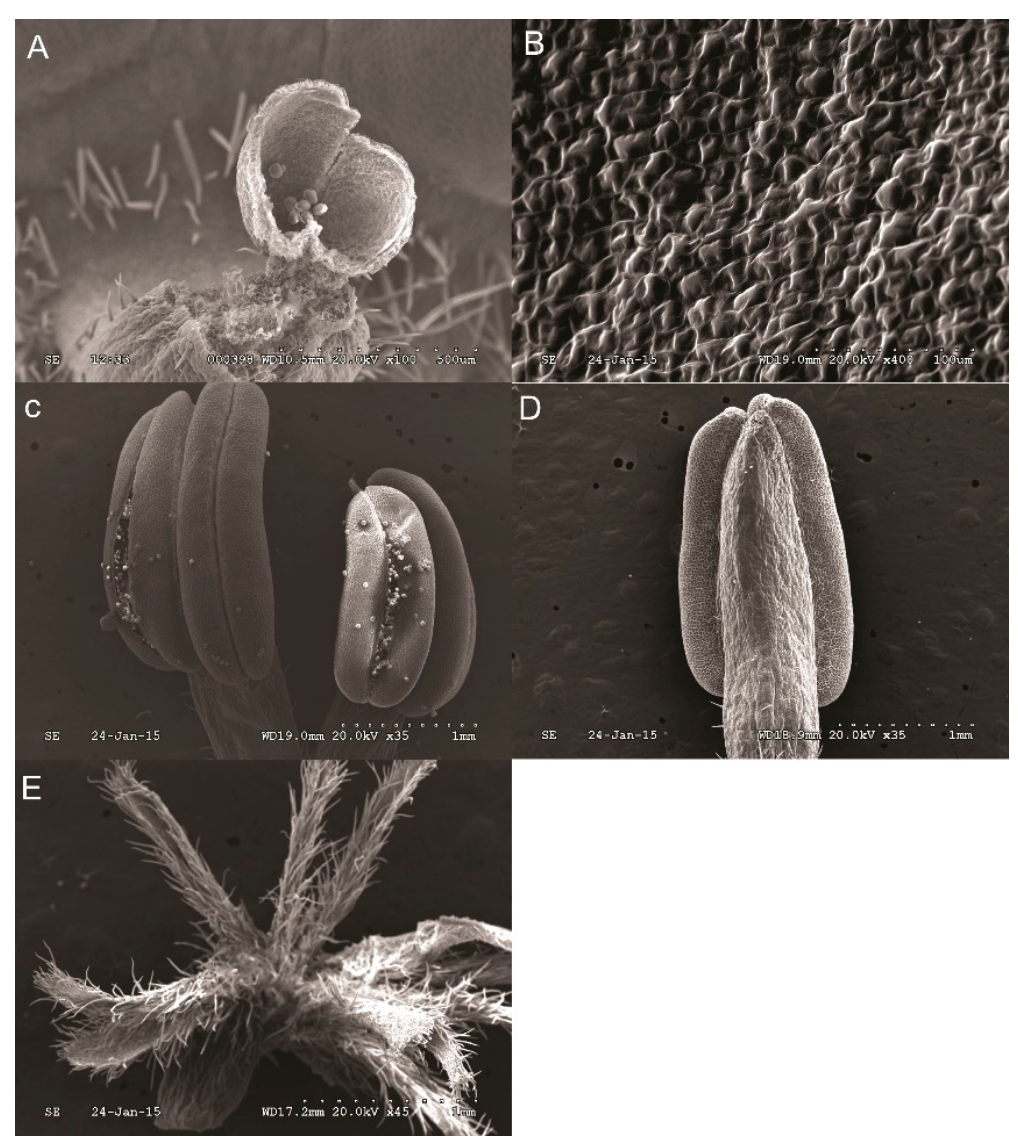
Figure 2. No nectaries distribution of the stamen and pistil in OF in the Chimonanthus praecox by SEM. ( A ), receptacle; ( B ), perianth; ( C ), front of stamen; ( D ), back of stamen; and, ( E ), pistil.